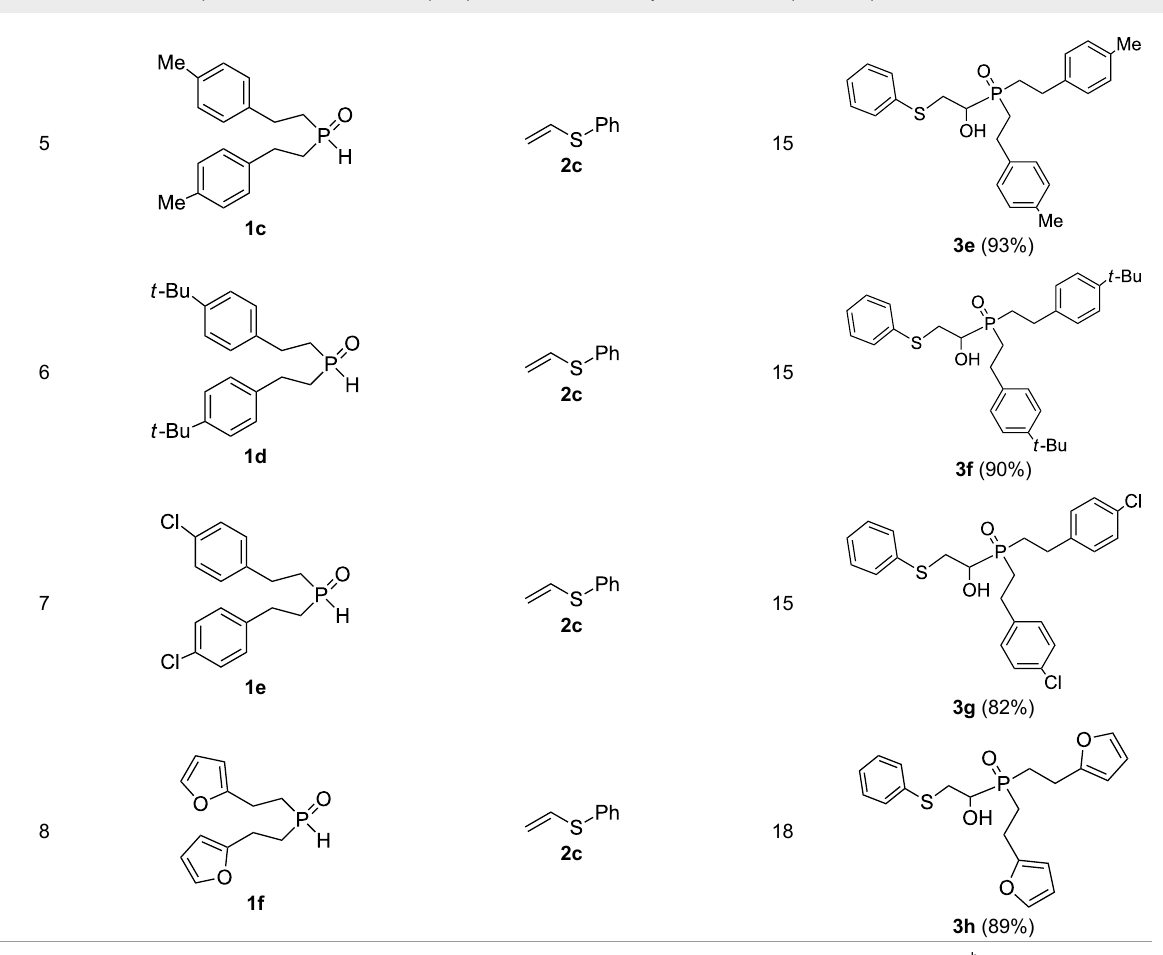
Table 1: The substrate scope for the aerobic addition of phosphine oxides 1a–f to vinyl sulfides 2a–c . a